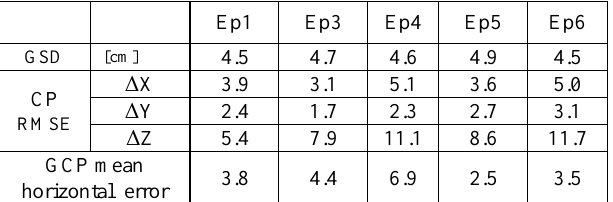
Table 2. CPs and GCPs RMSE results for Reference Ground Control Point- based co-registration (Epochs 1-6).